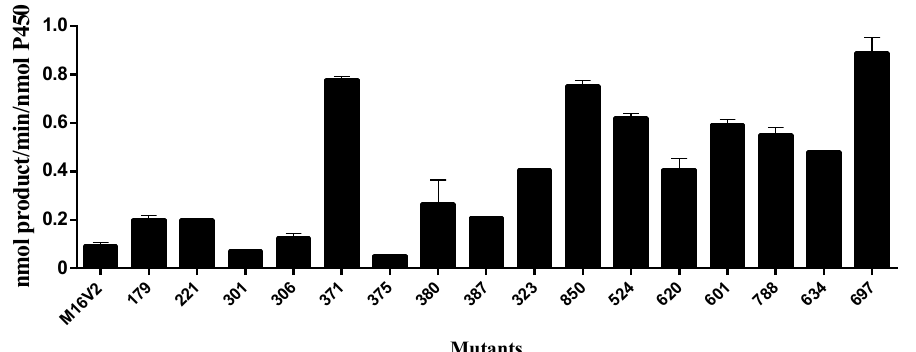
Figure 3. Hydroxylation rate of the monacolin J catalyzed using CYP102A1 mutants. The M697 showed the highest hydroxylation activity among the tested mutants. The rates of the major product formation using 17 mutants are presented as the mean ± SEM of triplicate measurements.